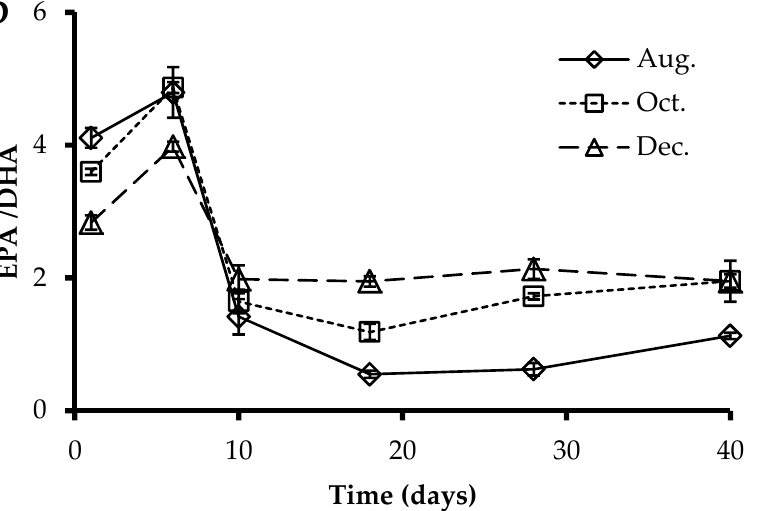
Figure 5. ( A – C ) The percentage of EPA, DHA, and ARA composition in larvae sampled in 1, 6, 10, 18, 28, and 40 dph in August, October, and December spawning events. ( D ) The percentage of DHA/EPA ratio is shown.